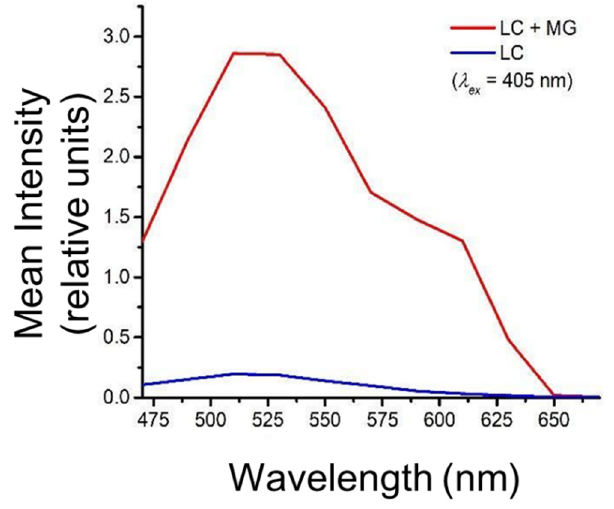
Figure 2. Mean intensity of confocal lambda-scans over the range of 470–670 nm with a 405 nm excitation.